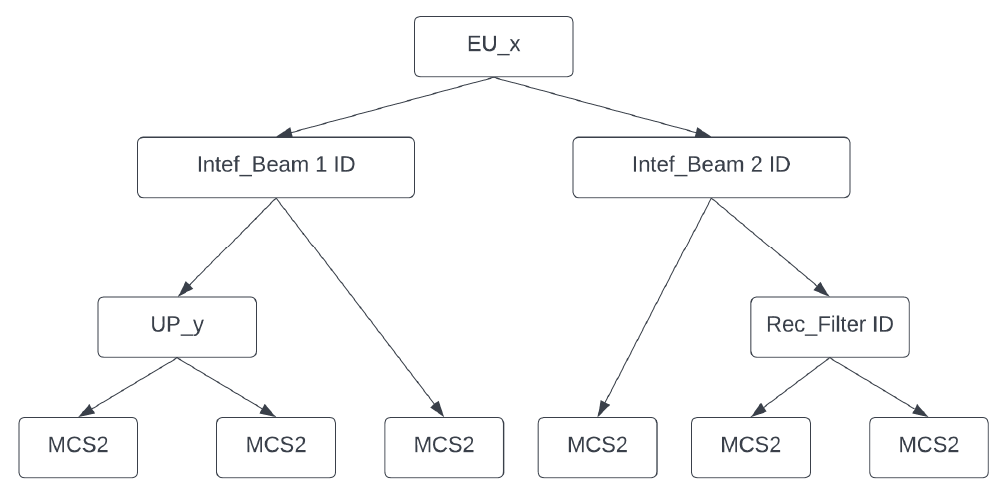
Figure 4. Position estimation of EU based on MCS .